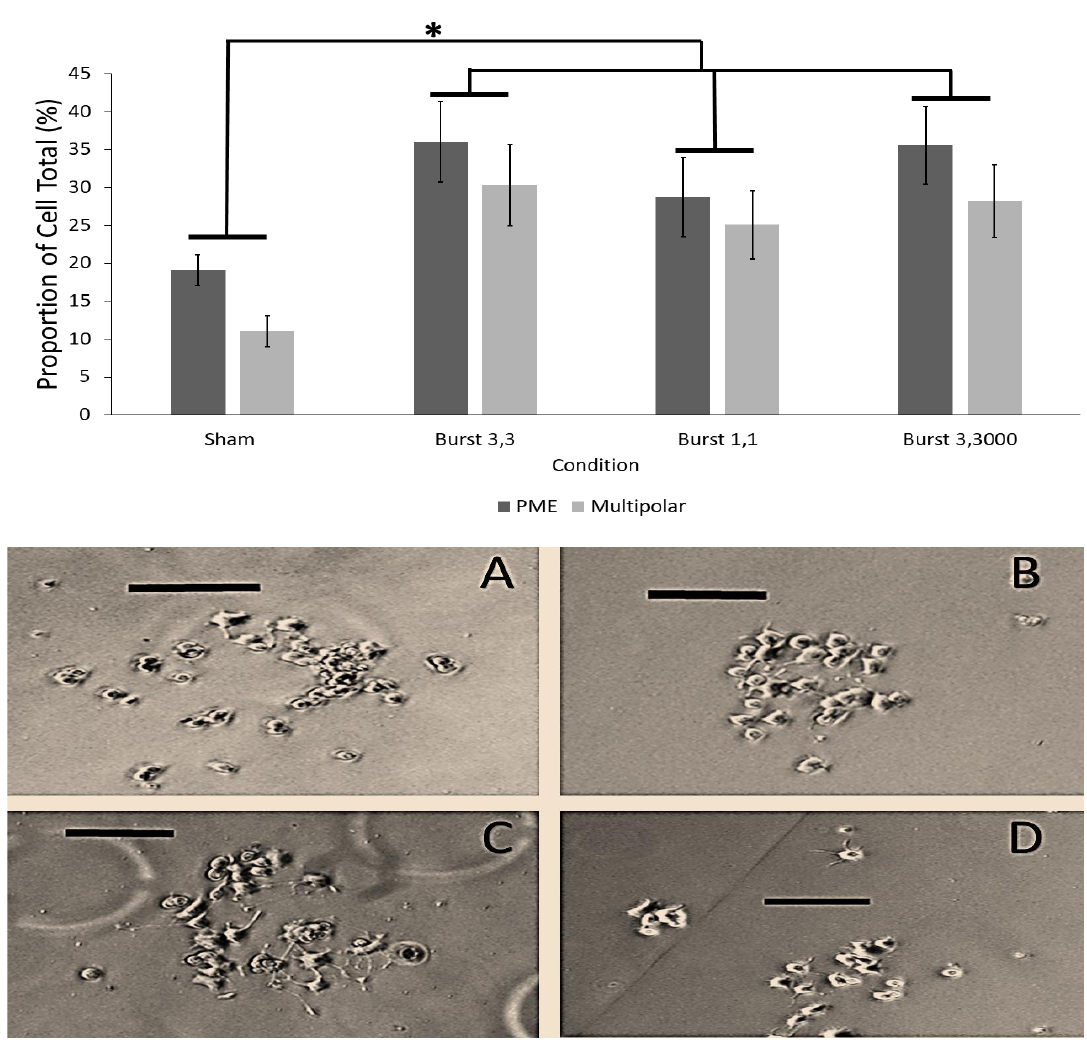
Figure 3. The graph (upper panel) shows the the proportion of PC12 cells expressing PME (dark bar) and multipolar extensions (light bar) as a function of exposure to different PD and ISI settings for the Burst-firing EMF. Error bars represent SEM. * indicates significant differences between groups ( p < 0.05). The photo shows representative samples of PC12 cells 3 days after exposure to ( A ): 1 h Sham exposures; ( B ), Burst-firing EMF with PD: 3 msec, ISI: 3 msec; ( C ), Burst-firing EMF with PD: 1 msec, ISI: 1 msec; and, ( D ), Burst-firing EMF with PD: 3 msec, ISI: 3000 msec. Darkened bars were fitted to original microscope photos and adjusted for clarity. Individual darkened bars approximate 100 um in length. As discussed previously, sham treatments are PC12 cells treated with forskolin only, while all EMF exposures were treatments where cells received both forskolin treatment and EMF. For each exposure condition, 2 plates were conducted in parallel within a given trial, 4 photos were sampled from each plate for cell counting in a given trial, and all trials were triplicated for each condition. Sham conditions were replicated 12 times; each Sham exposure consisted of 2 plates conducted simultaneously and 4 photos were sampled from each plate to assess cell morphology.